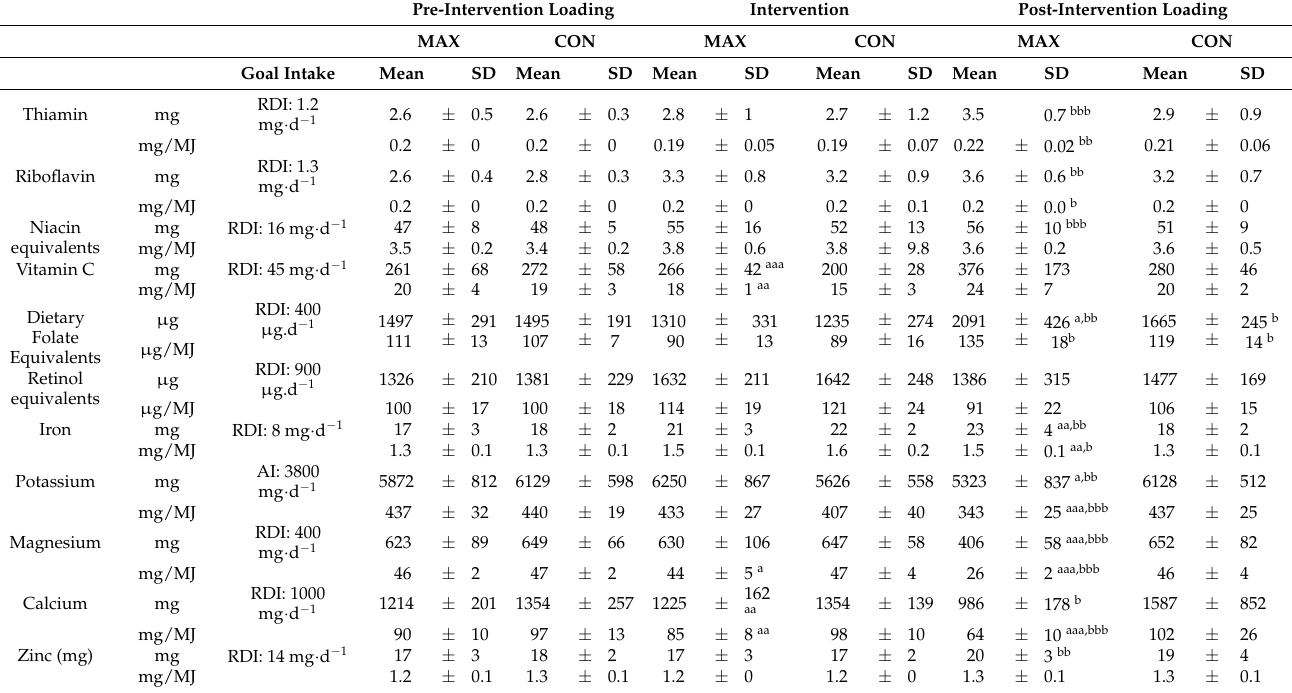
Table 3. Micronutrient intakes during pre-race CHO loading phases (pre- and post-interventions) and a 14-day dietary intervention involving high CHO availability (MAX) versus moderate CHO availability (CON) in highly trained distance runners. Pre-Intervention Loading Intervention Post-Intervention